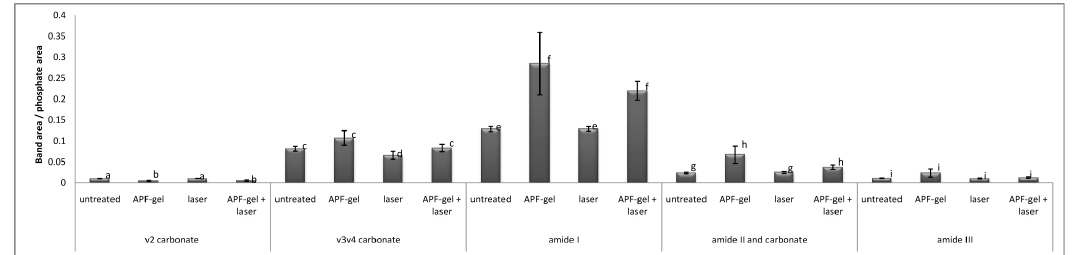
Figure 2. Means of ν 2 carbonate/phosphate, ν 3 ν 4 carbonate/phosphate, amide I/phosphate, amide II and carbonate/phosphate, and amide III/phosphate ratios obtained from dentin samples immediately after treatments. Bars denote standard errors. Distinct letters indicate statistically significant differences ( p < 0.05) according to Kruskal-Wallis and Student-Newman-Keuls test. In Figure 3, where d is the interplanar space, it is evidenced that the comparison of hydroxyapatite (JCPDF 09-0432) and tetracalcium phosphate (TetCP, JCPDF 25-1137) Bragg peaks with the peaks observed in X-ray diffraction analysis of untreated dentin and dentin irradiated with Nd:YAG laser. More detailed X-ray patterns of two untreated and two irradiated dentin samples are exposed in Figure 4. Untreated dentin showed diffraction peaks that match with the hydroxyapatite Bragg peaks. However, laser irradiated dentin presented some new additional Bragg peaks when compared to untreated dentin (blue arrows), close to the diffraction peaks of the expected pattern for TetCP. No changes on X-ray diffraction patterns of dentin were observed due to APF application when compared to untreated dentin; as well, the application of APF before Nd:YAG laser irradiation did not promote additional changes on the diffraction patterns of dentin when compared to Nd:YAG laser irradiation alone.